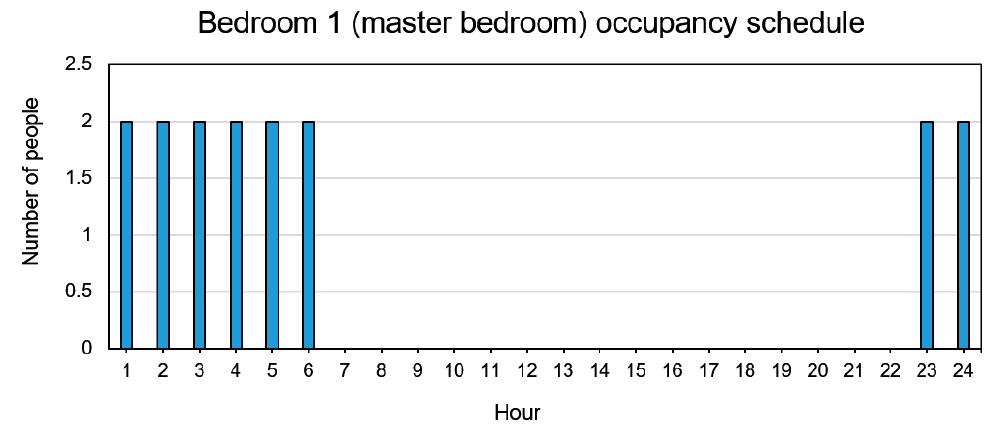
Figure 23. Bedroom 1 occupancy schedule.